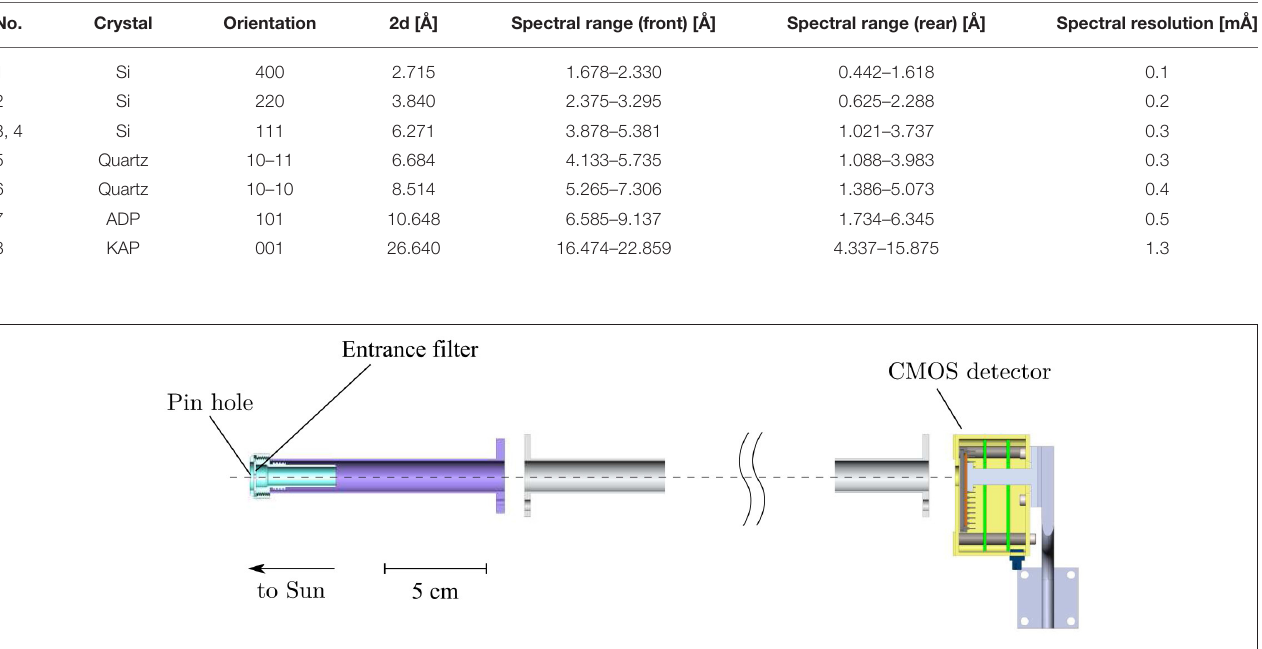
Frontiers in Astronomy and Space Sciences |